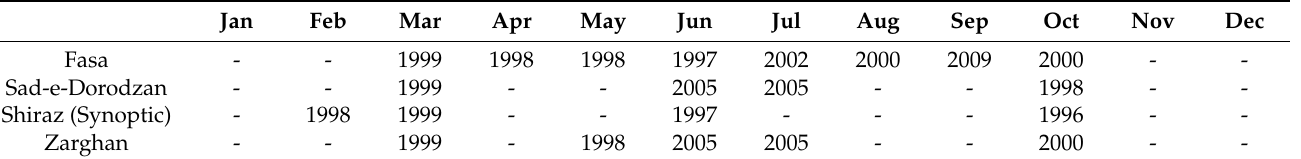
Note: These values were deemed statistically significant at α = 0.05. Table 5. Changing points detected in the monthly temperature time series of selected stations.